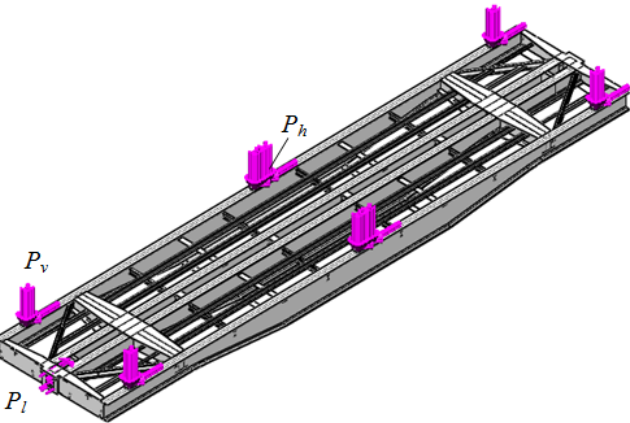
Figure 1. Design diagram of the flatcar frame.